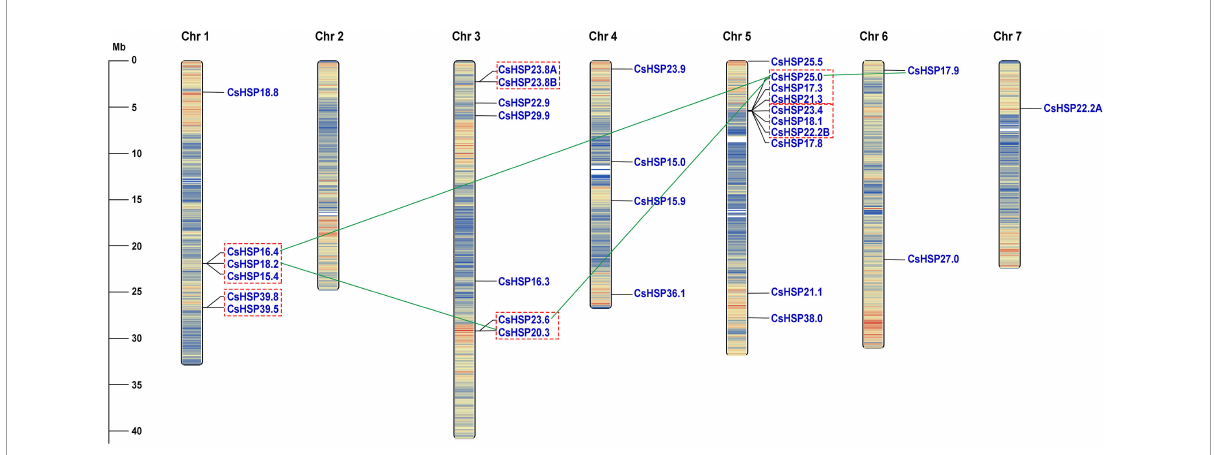
FIGURE1 Chromosomal locations of CsHSP20 genes. Tandem duplicated genes are indicated by red dashed box and segmental duplicated genes are connected by green line. Chromosome numbers are shown at the top of each bar. The scale presented on the left indicates chromosome sizes in mega bases (Mb).